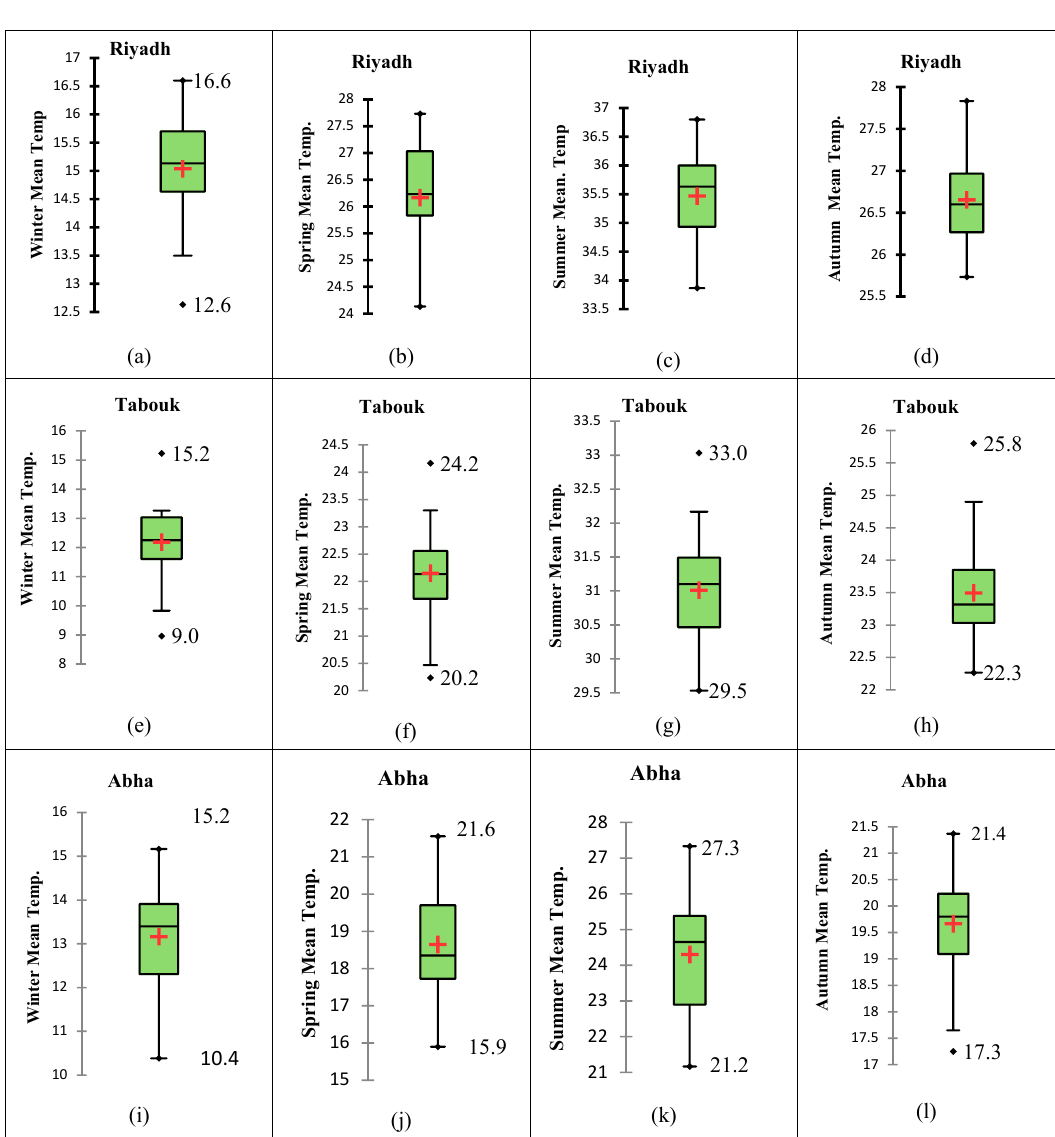
Figure 2. Box plots of mean temperature for different seasons in Riyadh, Tabouk and Abha representing the central, north and southwest regions of Saudi Arabia. ( a – d ): winter, spring, summer and autumn in Riyadh respectively. ( e – h ): winter, spring, summer and autumn in Tabouk respectively. ( i – l ): winter, spring, summer and autumn in Abha respectively. Bottom and top of the boxes represent the first quartile (Q1) and the third quartile (Q3) respectively. The lower whisker extends up to (Q1 − 1.5 × (Q3 − Q1)) and upper whisker extends up to (Q3 + 1.5 × (Q3 − Q1)). The horizontal lines within the box represent the medians of the data. Values larger than Q3 or smaller than Q1 by at least 1.5 times the interquartile range (IQR) are outliers. The (+) sign indicates the mean values of the data. North Region Southwest The summer mean temperature (31 °C) was almost 2.5 times the winter mean temperature (12.2 °C), indicating the continental climate (Table 1). The skewness were small (range: − 0.38–0.54) while standard deviation (range: 0.69–1.6) and CV (range: 0.023–0.147) were low (Table 1), indicating the